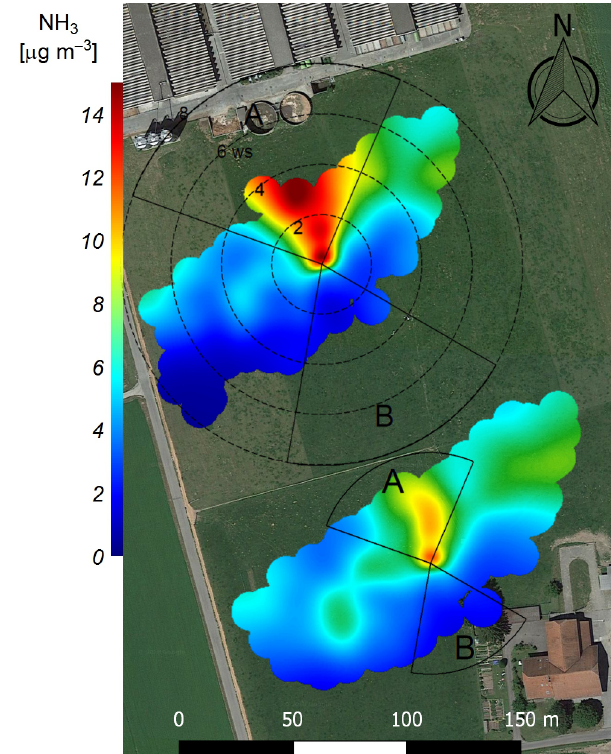
Figure 2. The polar plot shows the averaged NH 3 concentration of the miniDOAS MD5 (top) and MD6 (bottom) depending on wind direction and wind speed (black dotted circles) for the period May– October 2016. The sectors A and B indicate areas with either high NH 3 concentration from farm buildings or otherwise unfavourable wind direction due to the measurement set-up. The polar plots were produced using the R software package openair (Carslaw and Rop- kins, 2012) and overlaid on a Google Earth image of the experimen- tal area (map data: Google,